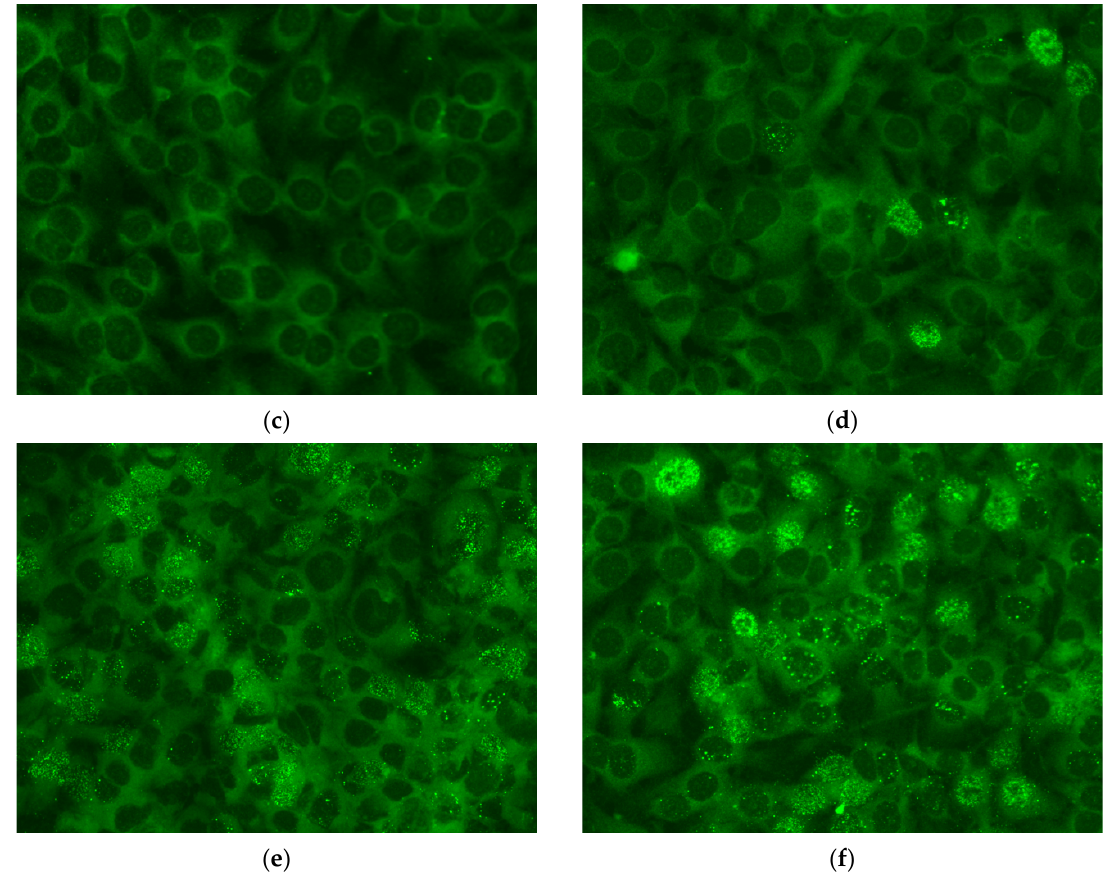
Figure 1. ( a ) Infectivity assay: CEC-32 cell culture with immunofluorescence of PaBV-specific antigen—juvenile group, yolk sample J11/54 (positive), 200× total magnification; ( b ) infectivity assay: CEC-32 cell culture with immunofluorescence of PaBV-specific antigen—juvenile group, yolk sample J3/4/55 (negative), 200× total magnification; ( c ) infectivity assay: CEC-32 cell culture with immunofluorescence of PaBV-specific antigen—adult group, embryo C0.1/61 (negative), 200× total magnification; ( d ) infectivity assay: CEC-32 cell culture with immunofluorescence of PaBV-specific antigen—adult group, yolk sample C0.1/53 (positive), 200× total magnification; ( e ) infectivity assay: CEC-32 cell culture with immunofluorescence of PaBV-specific antigen—juvenile group, embryo J3/4/77 (positive), 200× total magnification; ( f ) infectivity assay: CEC-32 cell culture with immunofluorescence of PaBV-specific antigen—juvenile group, brain J11/76 (positive), 200× total magnification.